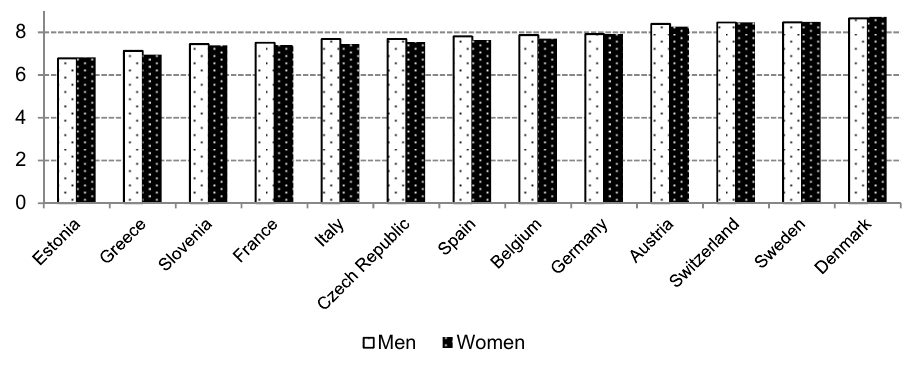
Source : SHARE (2015): wave